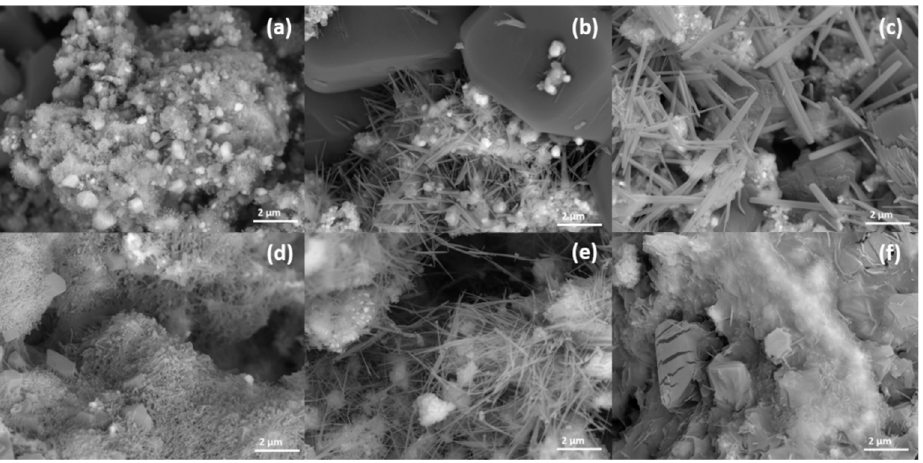
Figure 6. SEM images of the catalysts at 5Kx magnification: ( a ) CVI60, ( b ) CVI70, ( c ) CVI80, ( d ) CVI90, ( e ) IW, and ( f ) IMP.